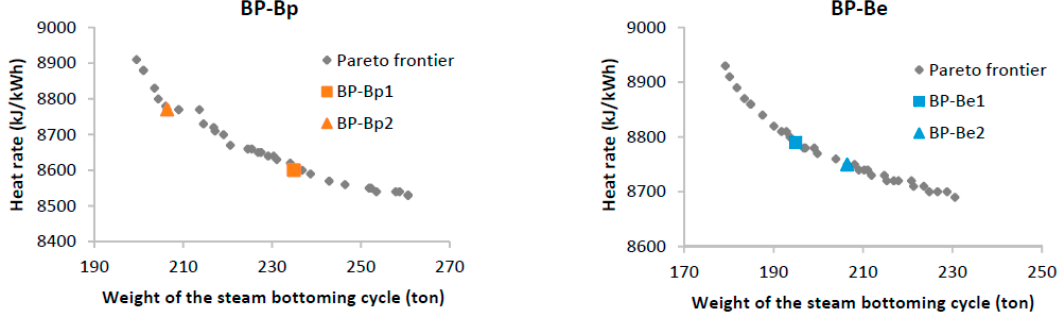
Figure A2. Pareto frontiers of backpressure steam turbine cycle for case B at peak (BP-Bp) and end-life (BP-Be) conditions.